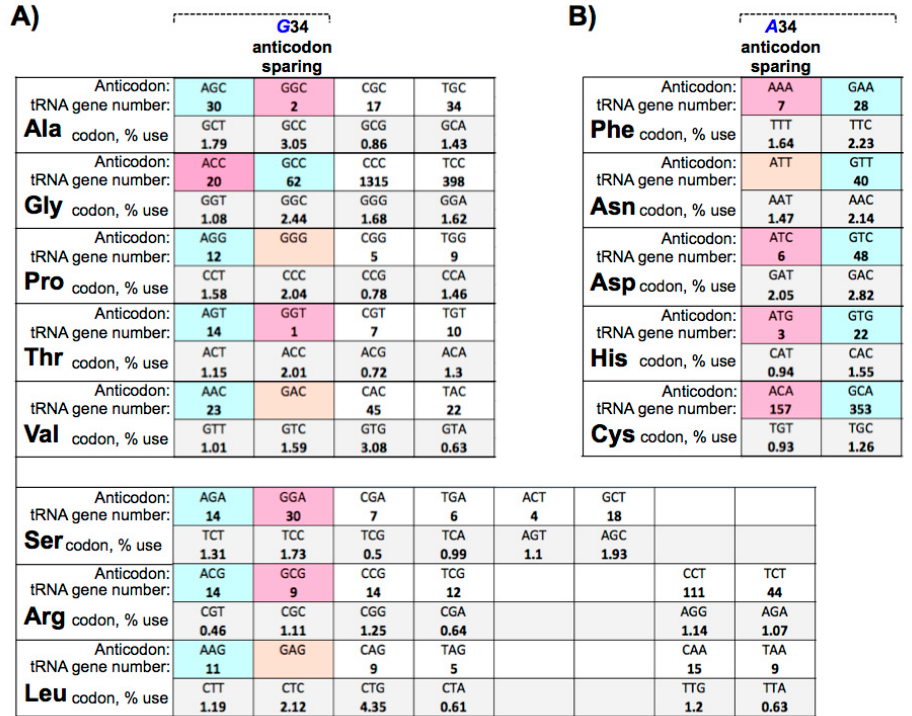
Figure 2. Example of disregard for G34 anticodon-sparing and A34 tRNA genes by the large tRNAome of Bos taurus (cow). The scheme is organized as for Figure 1 with same color code. This figure is a partial summary of the total number of tRNA genes which is 4161 obtained by tRNAscan-SE analysis (Baylor release Btau_4.0, October 2007) as can be found at